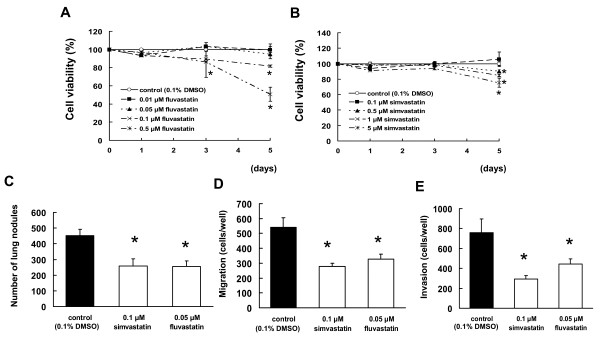
Inhibitory effect of statins on tumor cell metastasis, migration, and invasion. (A, B) Determination of the statin concentrations suitable for administration to B16BL6 cells. The cells were incubated in 96-well plates for 24 h and then treated with 0.01-0.5 μM fluvastatin, or 0.1-5 μM simvastatin. After 1, 3, or 5 d, cell viability was quantified by WST-8 assays. The results are representative of 5 independent experiments. (C) B16BL6 cells, which had been pretreated with 0.05 μM fluvastatin or 0.1 μM simvastatin for 3 d, were injected into the tail veins of syngeneic C57BL/6J mice. After 14 d, visible nodules that had metastasized to the lungs were counted. The results are expressed as the mean ± SD of 9 mice. (D, E) B16BL6 cells were pretreated with 0.05 μM fluvastatin or 0.1 μM simvastatin for 3 d, after which cells were seeded into the upper compartments of chambers. (D) Migration was analyzed by Boyden chamber assays using Falcon cell culture inserts. (E) Invasive properties were analyzed using Falcon cell culture inserts covered with 50 μg of Matrigel per filter. For both assays, the lower chambers contained conditioned media from NIH/3T3 cells cultured for 24 h, which was used as a chemoattractant. After incubation for 24 h, the cells invading the lower surface were counted microscopically. The results are representative of 5 independent experiments.